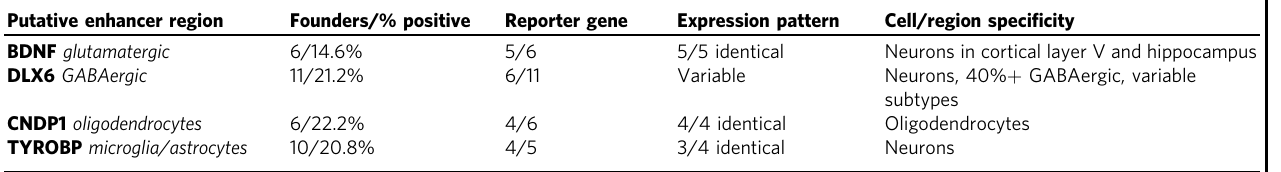
Table 2 Validation of putative enhancer regions by mouse transgenesis. Putative enhancer